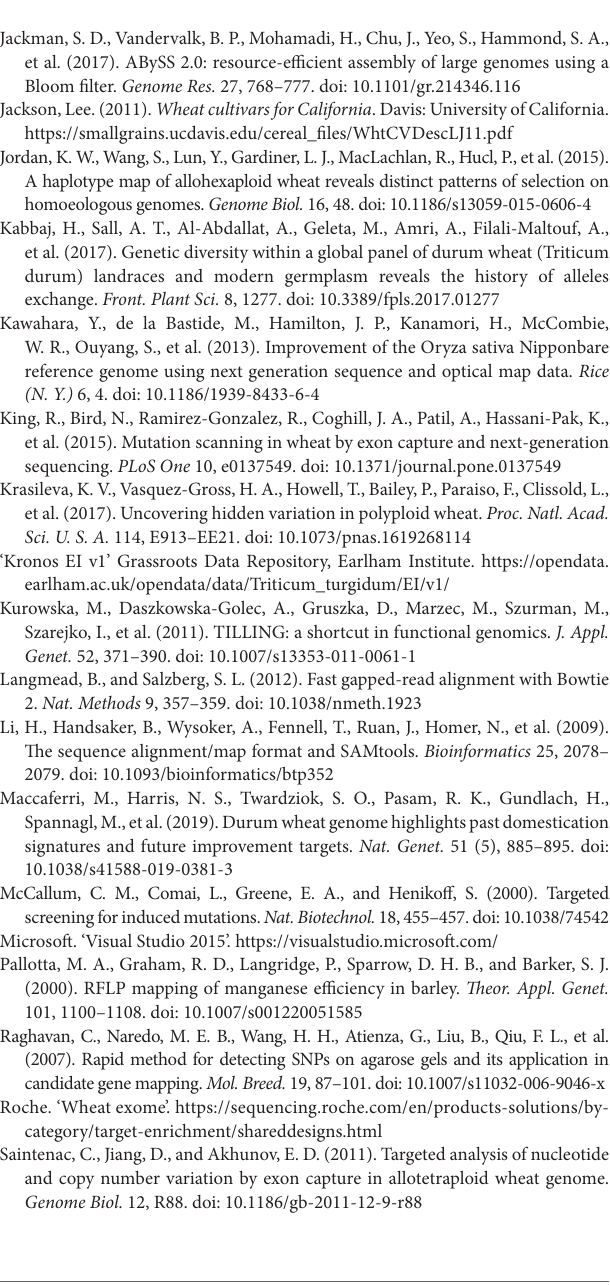
SUPPLEMENTARY TABLE 1 | Detailed information on alignment rates and mutations for each Tilling line. SUPPLEMENTARY TABLE 2 | BLAST search results for the assembled